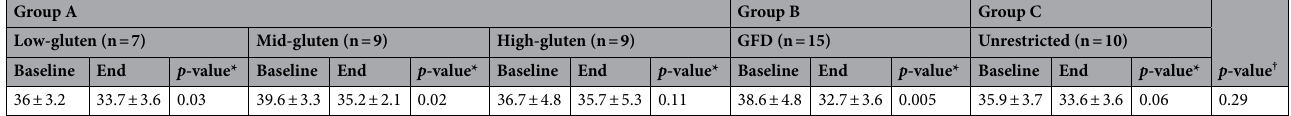
Table 5. Total scores on the Zung Self-Rating Anxiety Scale (SAS) in irritable bowel syndrome (IBS) patients within groups and between groups at the end of the study (Mann–Whitney U test was used for testing each two groups. There were no significant differences between each two groups). * p -value for comparison within each group using the Wilcoxon-signed rank test. † p -value for between-groups comparison using the Kruskal– Wallis